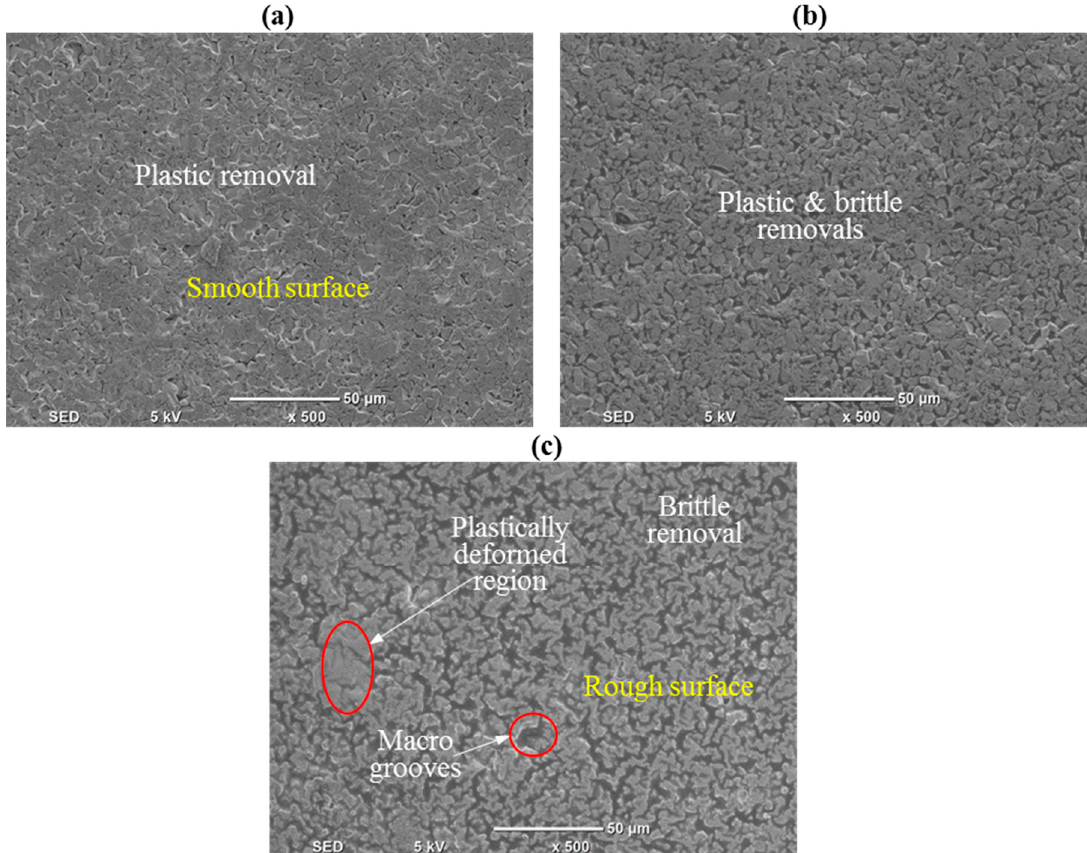
Figure 6. Scanning electron microscopy (SEM) micrograph of the machined channel for ( a ) Exp. #11, ( b ) Exp. #15, and ( c ) Exp. #32.